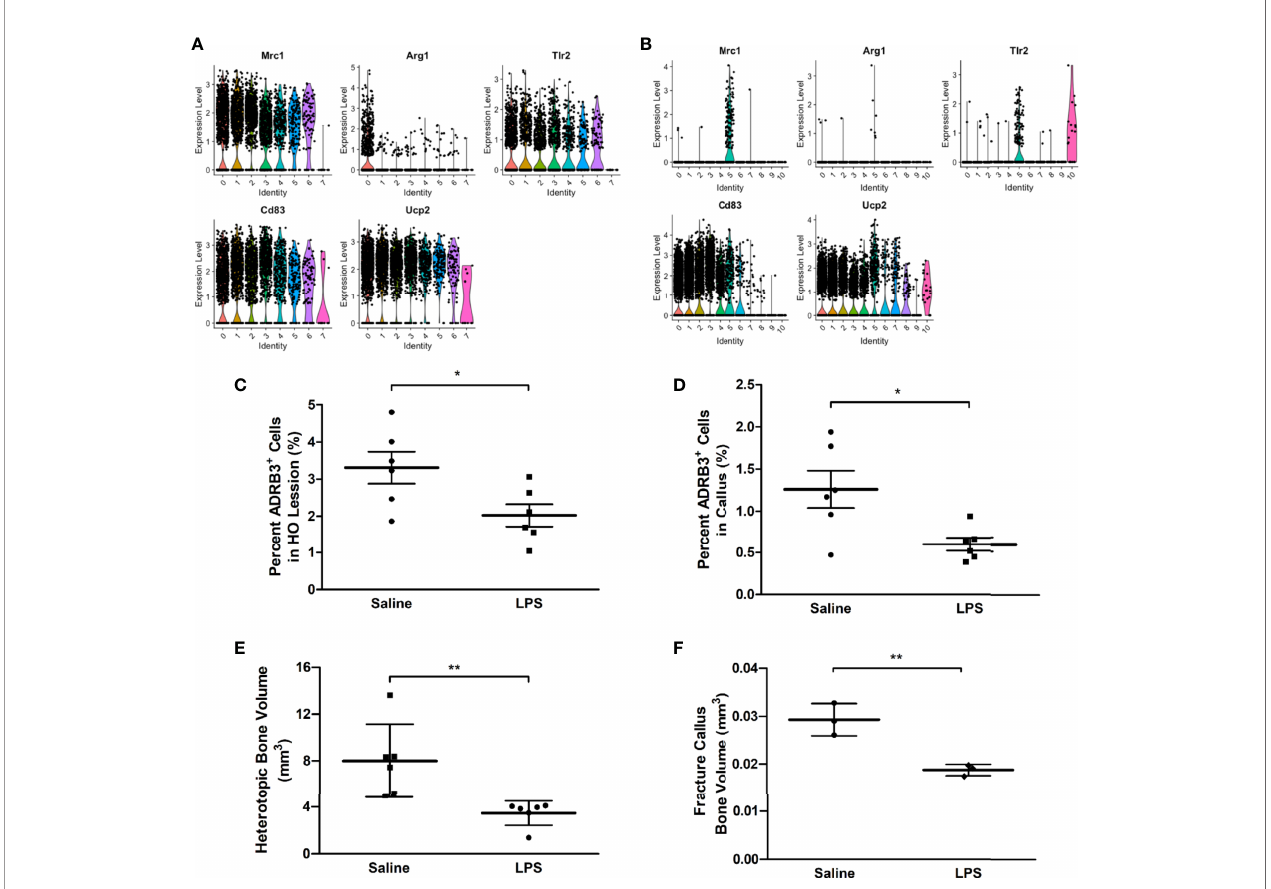
FIGURE 6 | ADR b 3+ macrophages appear to be M2-like and are reduced in number when in fl ammation is induced in mice using LPS. Transcriptome analysis of the ADR b 3+ macrophages isolated from (A) HO and (B) fracture callus show a signi fi cant number of genes selectively associated with M2 macrophages. ADR b 3 +cells were quanti fi ed from tissues undergoing (C) HO or (D) bone injury in mice undergoing a systemic in fl ammatory response. In addition, corresponding bone formation was measured for (E) HO and (F) fracture using microCT. Bone volume is depicted in the graphs. Signi fi cant differences (p<0.5) were calculated using an ANOVA with Tukey correction. Symbols represent sample data points, and horizontal lines depict the mean. Standard error of the mean (SEM) is shown by the capped vertical line. *p < 0.05, **p <